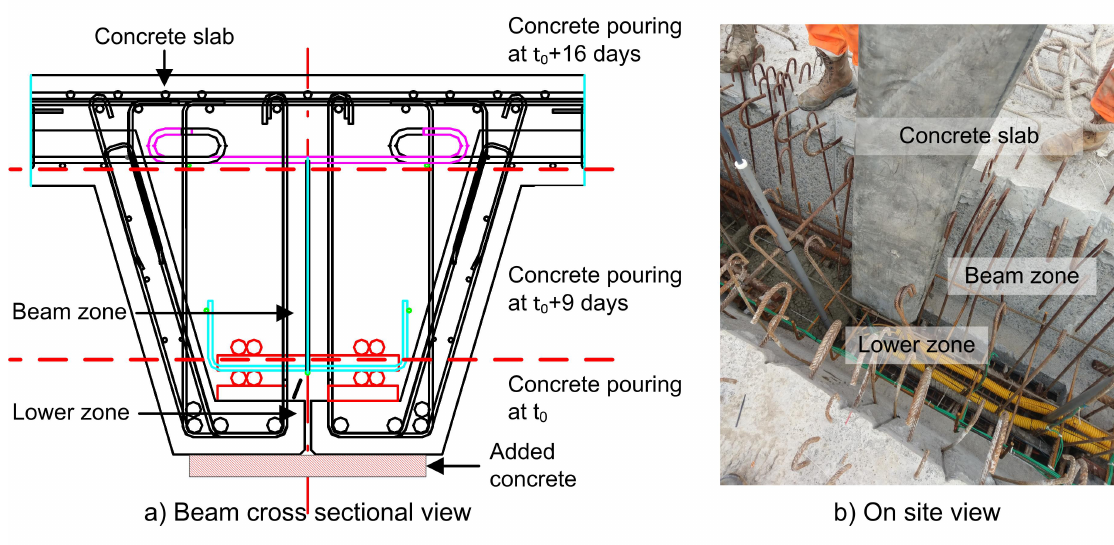
Figure 8. Identification of zones of the structure cast at different times.